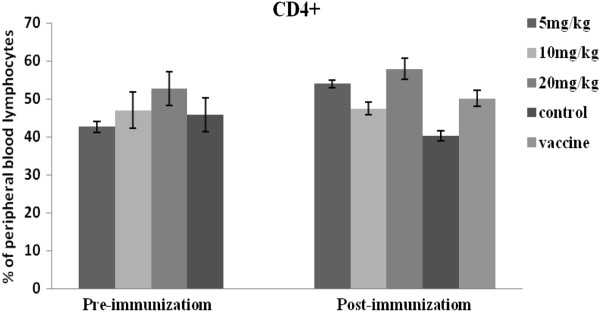
Illustrates the percentages of CD4 + T cell lymphocyte expression before and after immunization in vivo. CD4+ expression was greatest for the 20mg/kg APS group, both before and after immunization. CD4+ expression increased post immunization for the 5mg/kg APS group.